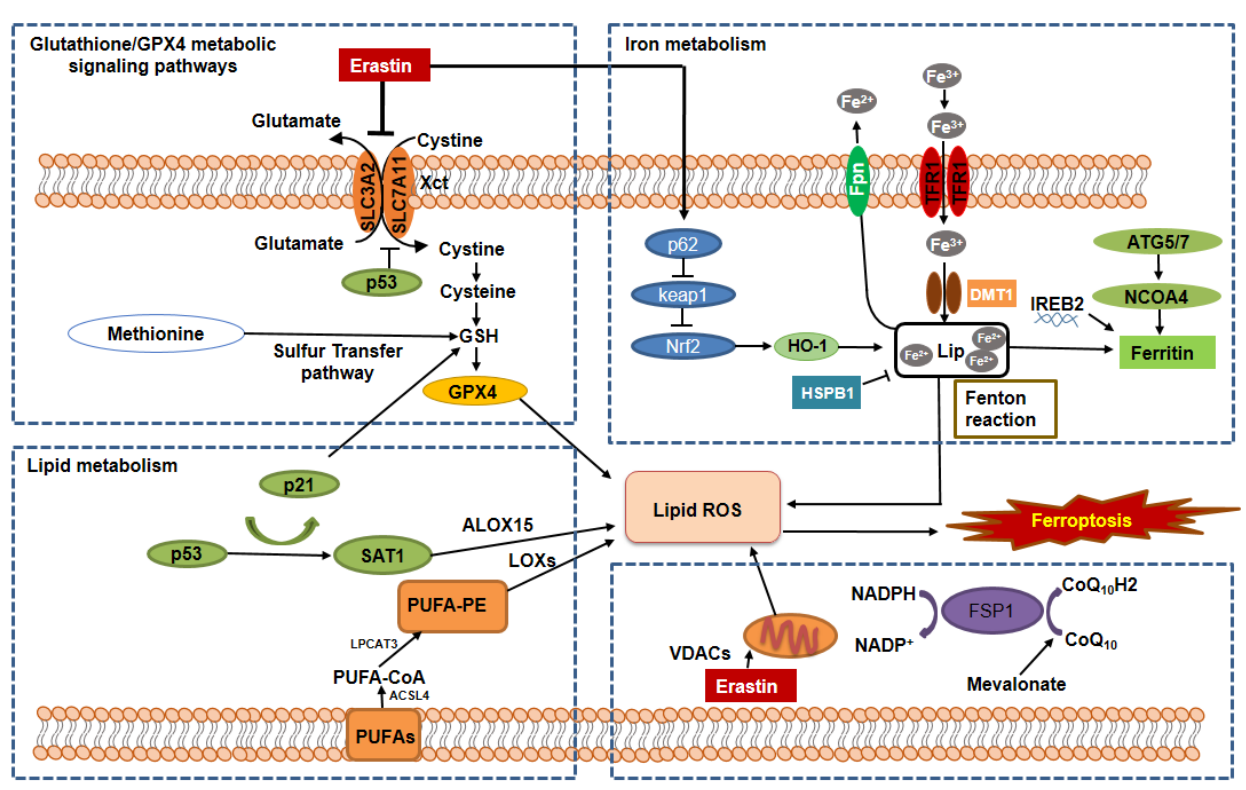
Figure 1. The mechanisms and signaling pathways regulate the metabolisms of glutathione/GPX4, iron, and lipid in ferroptosis. The hallmarks of ferroptosis include the loss of lipid peroxide repair capacity by the phospholipid hydroperoxidase GPX4, the availability of redox-active iron, and oxidation of PUFA-containing phospholipids, which are regulated by the following signaling pathways. 1. Glutathione/GPX4 signaling pathways. The synthesis of tripeptide GSH protects cells from ferroptotic death, in that GSH is essential: (i) for the maintenance of the level of GPX4 through the exchange of glutamate and cystine via cystine/glutamate antiporter system Xc-, and (ii) for the functional activity of GPX4 to reduce lipid hydroperoxides (L-OOH) to lipid alcohols (L- OH), resulting in the prevention of the iron (Fe 2+ )-dependent formation of toxic lipid ROS. The in- hibition of system Xc- or inhibition of GSH synthesis should result in lipid peroxides accumulation and ferroptotic cell death through inactivating GPX4. In addition, the mevalonate pathway, sulfur transfer pathway, glutamine pathway, and p53 signaling axis are also involved in the regulation of GPX4 activity and function. 2. Iron metabolic signaling pathway. Iron metabolism includes iron